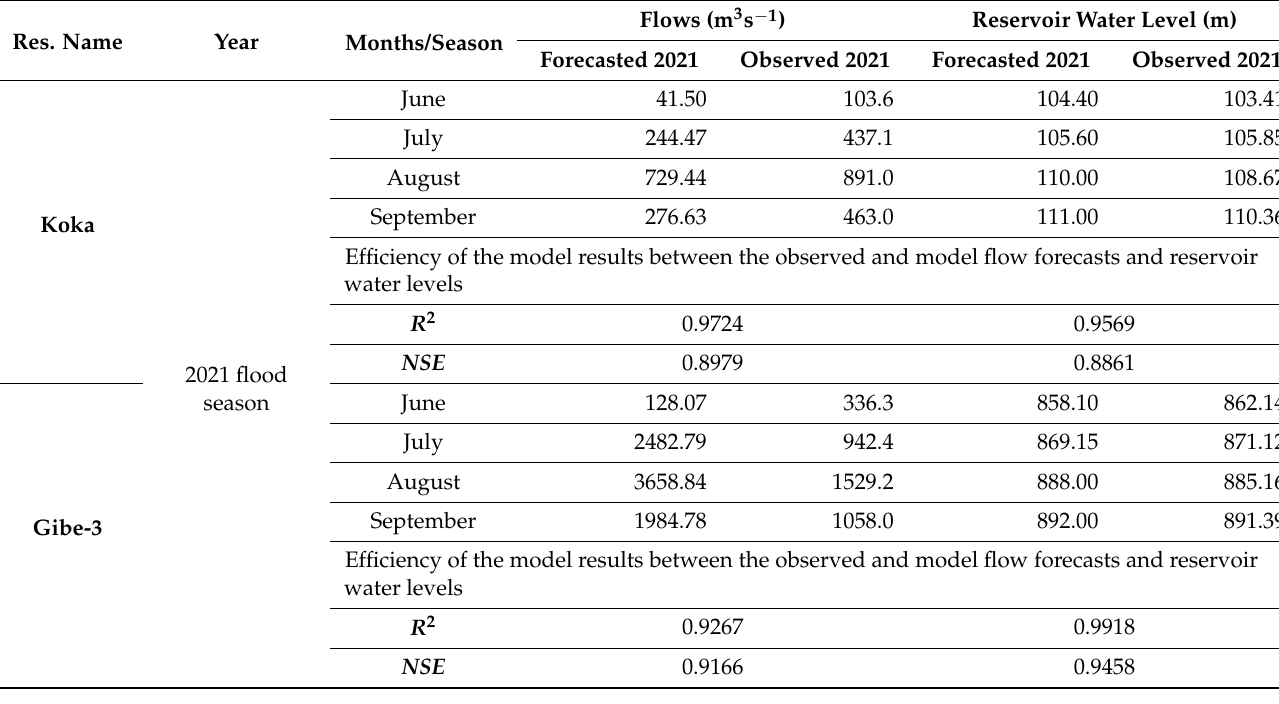
Table 4. Verification analysis of observed and forecasted flows and water levels for 2021.